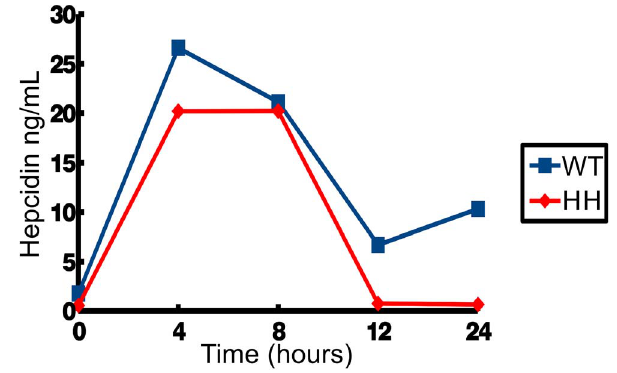
Figure 2. Simulated time course concentrations of hepcidin in response to changing serum transferrin-bound iron levels. The model shows similar dynamics to time course samples from patients measured by mass spectrometry and ELISA by Girelli et al. , 2011 [24]. Hereditary haemochromatosis simulations show reduced hepcidin levels and peak response compared to WT (Wild Type).